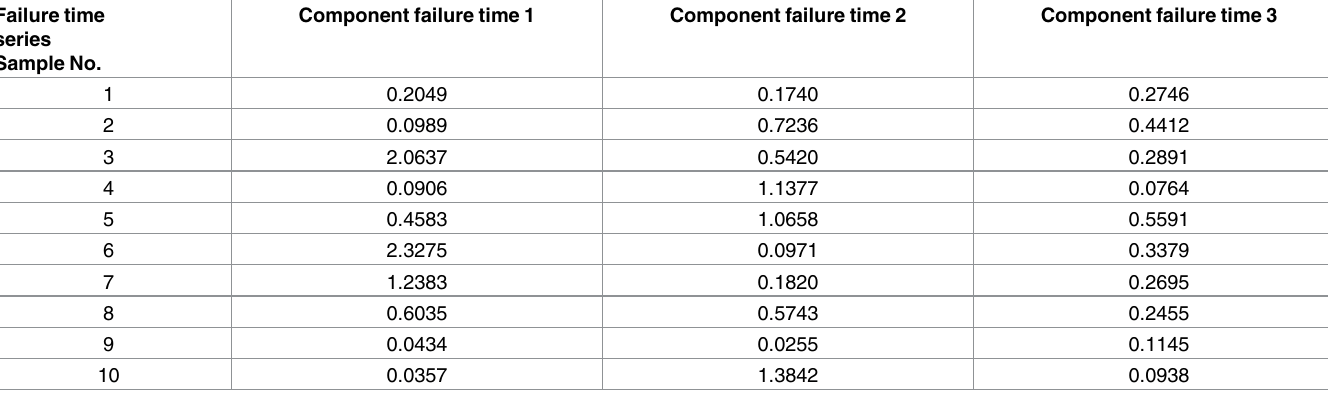
Table 2. Simulated data set for exponential numerical example. Failure time series Sample